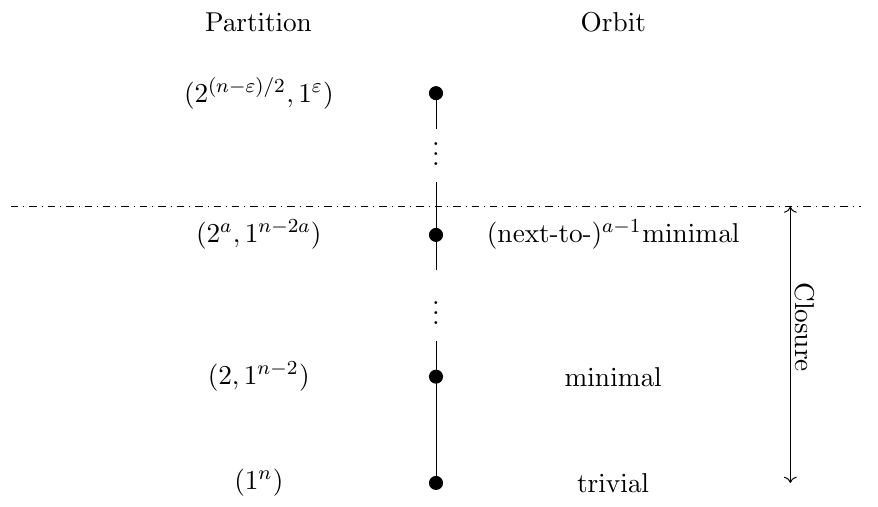
Figure 26 . The height two part of the Hasse diagram of sl ( n, C ), along with the common names for the orbits. Here ε = 0 if n is even and ε = 1 if n is